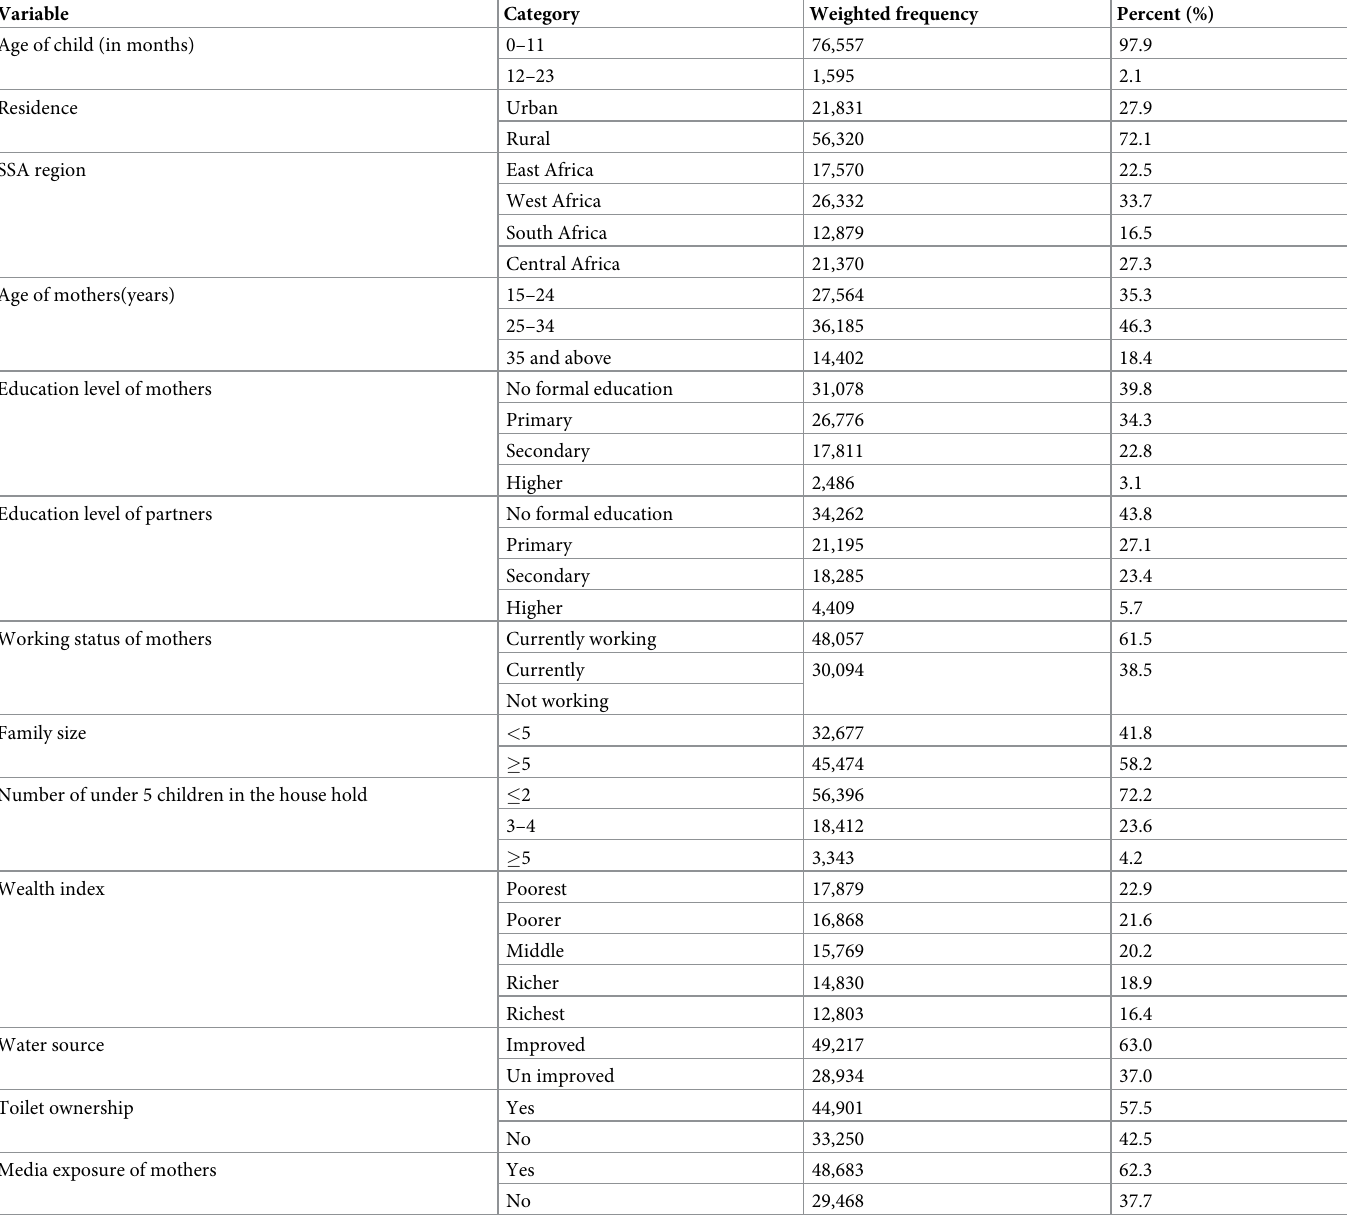
Table 2. Sociodemographic characteristics of the respondents in sub-Saharan Africa, 2020.